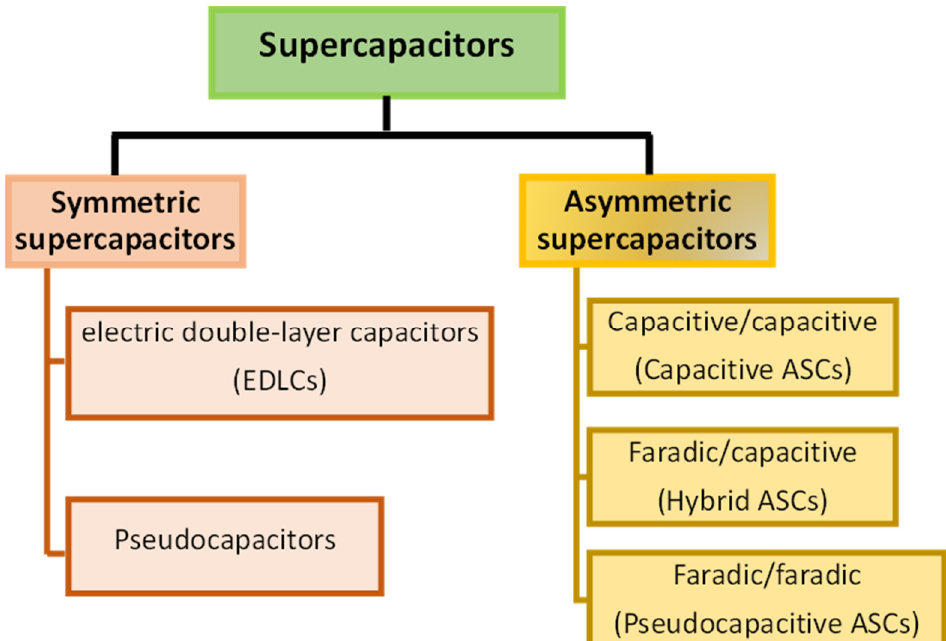
Figure 2. Supercapacitor